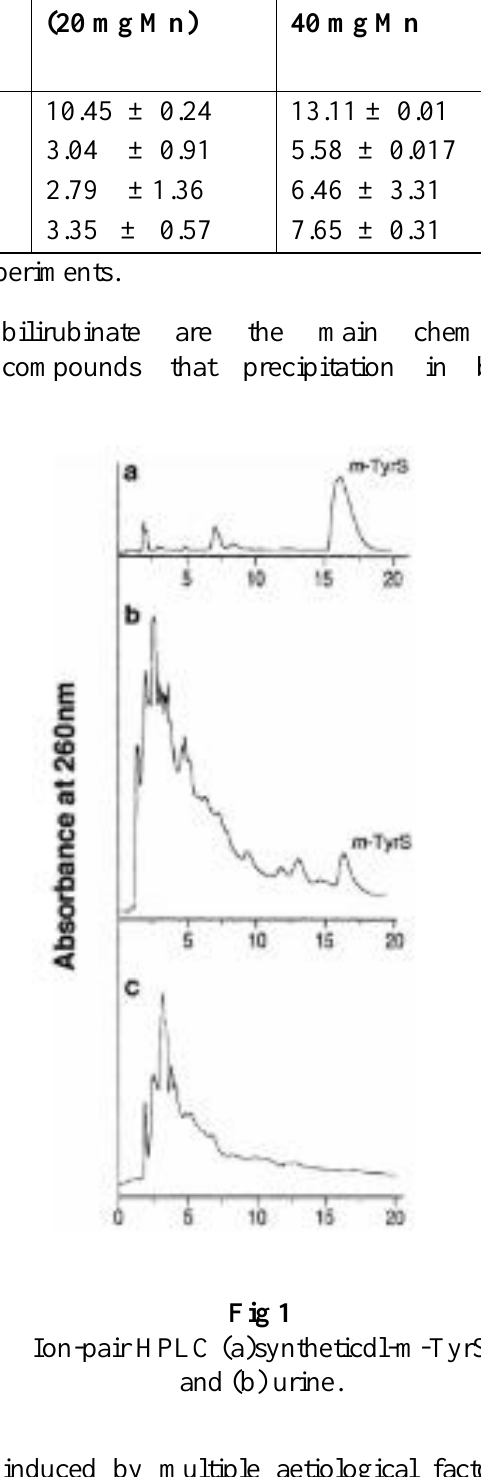
Table 2: Manganese accumulation in different organs in different experimental groups of rats Organ